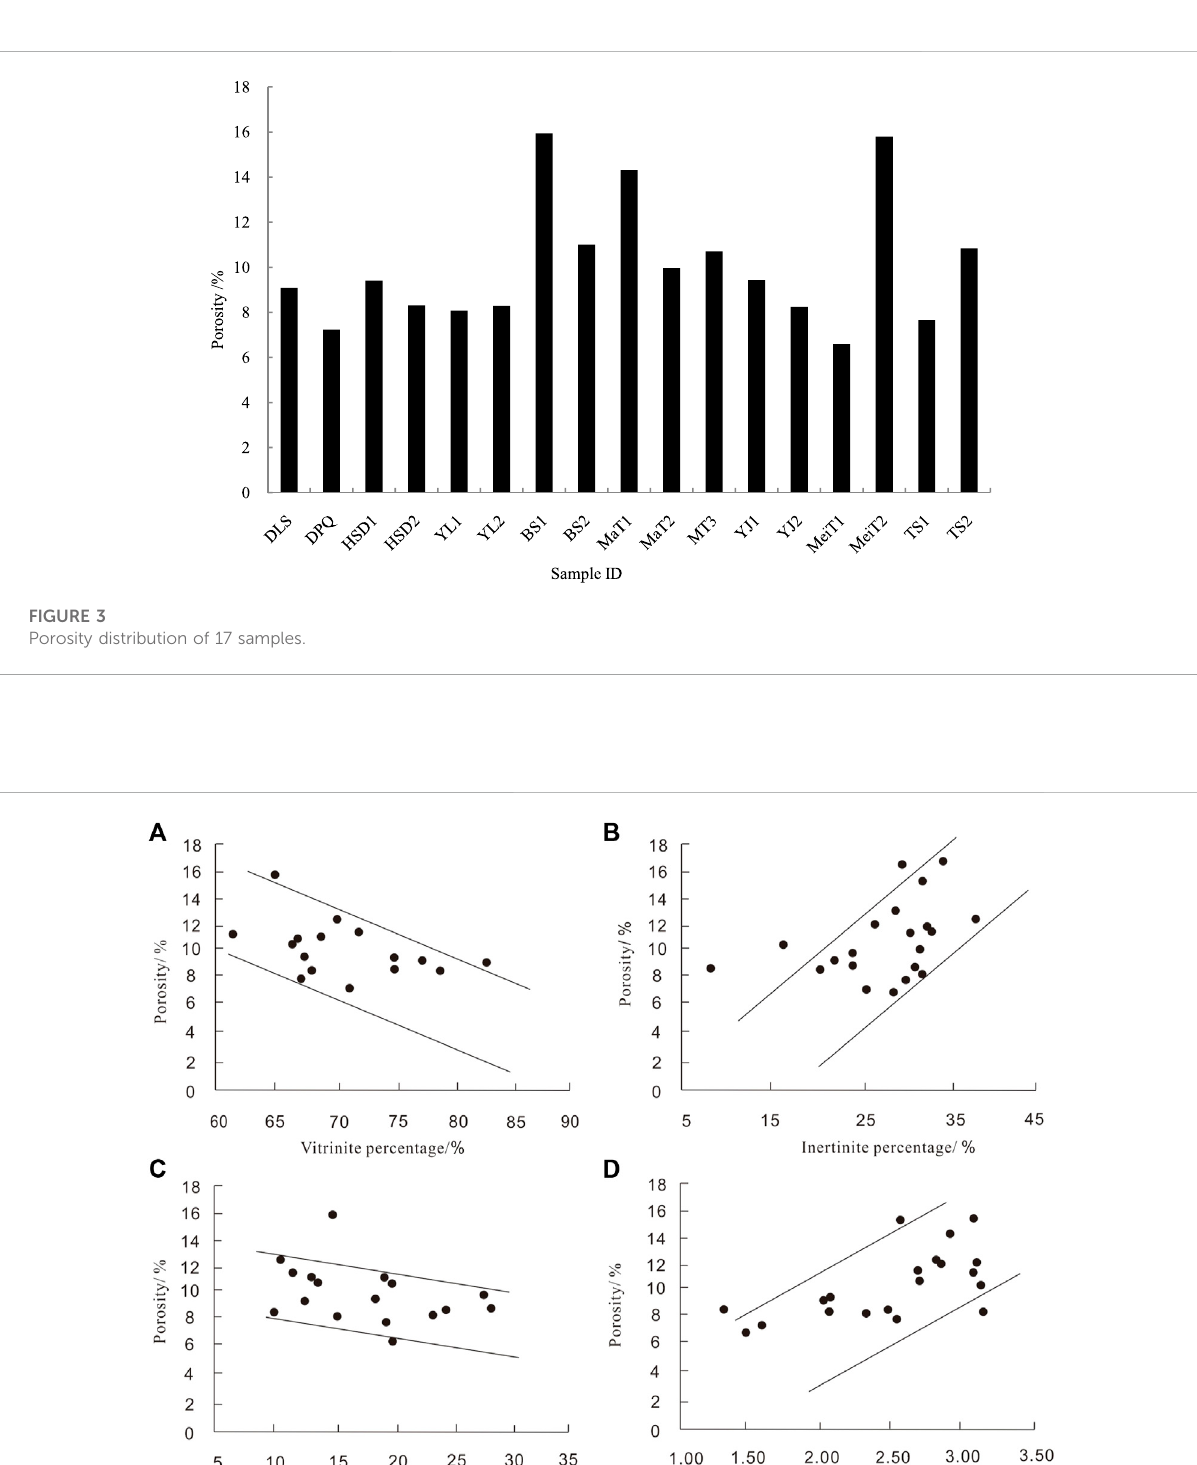
Frontiers in Earth